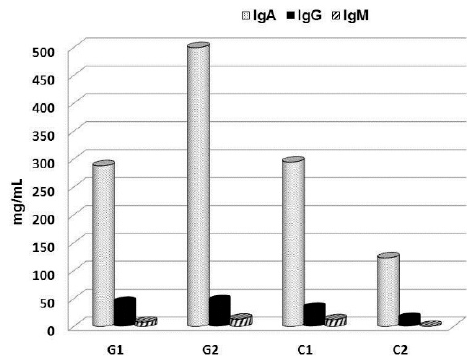
Figure 5. Changes in salivary immunoglobulins after 30 day supplementation in children with respiratory problems. G—glucan group, C—placebo group.